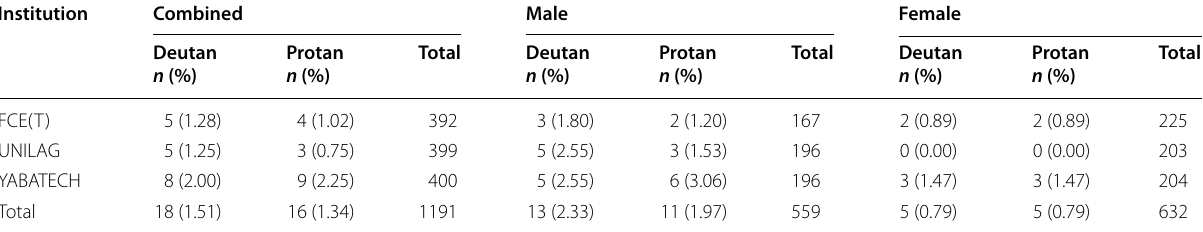
Table 3 Prevalence of different types of CVD among male and female students of FCE(T), UNILAG and YABATECH Institution